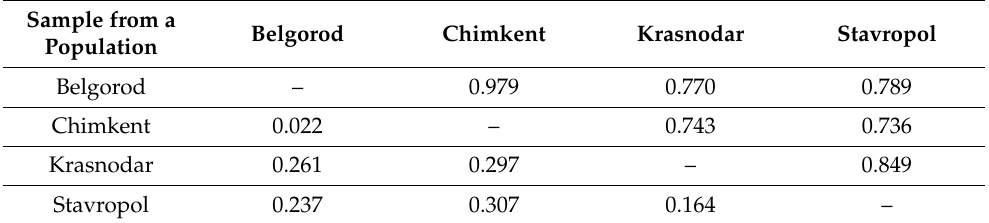
Table 4. Genetic distances (GD) (under diagonal) and genetic identity (GI) (above diagonal) between populations of Habrobracon.